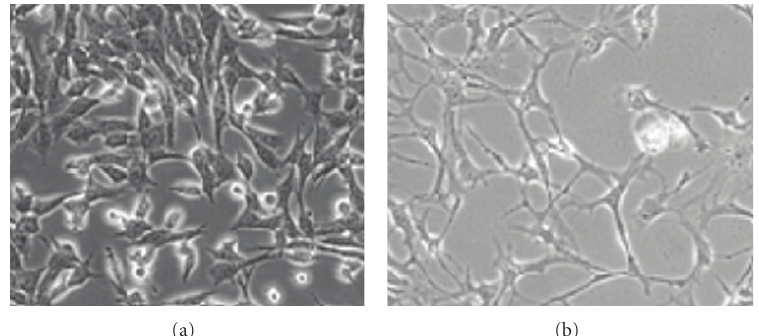
Figure 1: Morphological changes in RGC-5 cells after treatment with HNPE conditioned SF-medium (40x) (a) before, and (b) after. The RGC-5 cells treated with HNPE conditioned SF-medium induced morphological changes, including longer axons and more neurite outgrowth (Figure 1(b)), compared to RGC-5 cells without treatment (Figure 1(a)).